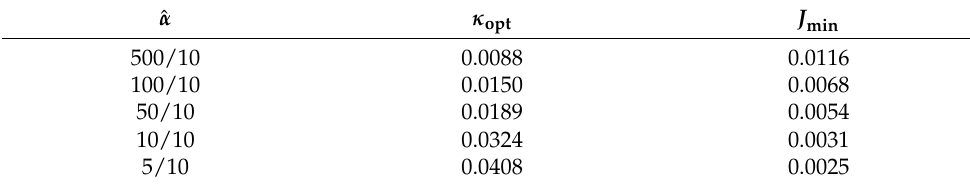
Table 3. Weighting factor/optimal parameter/minimum performance